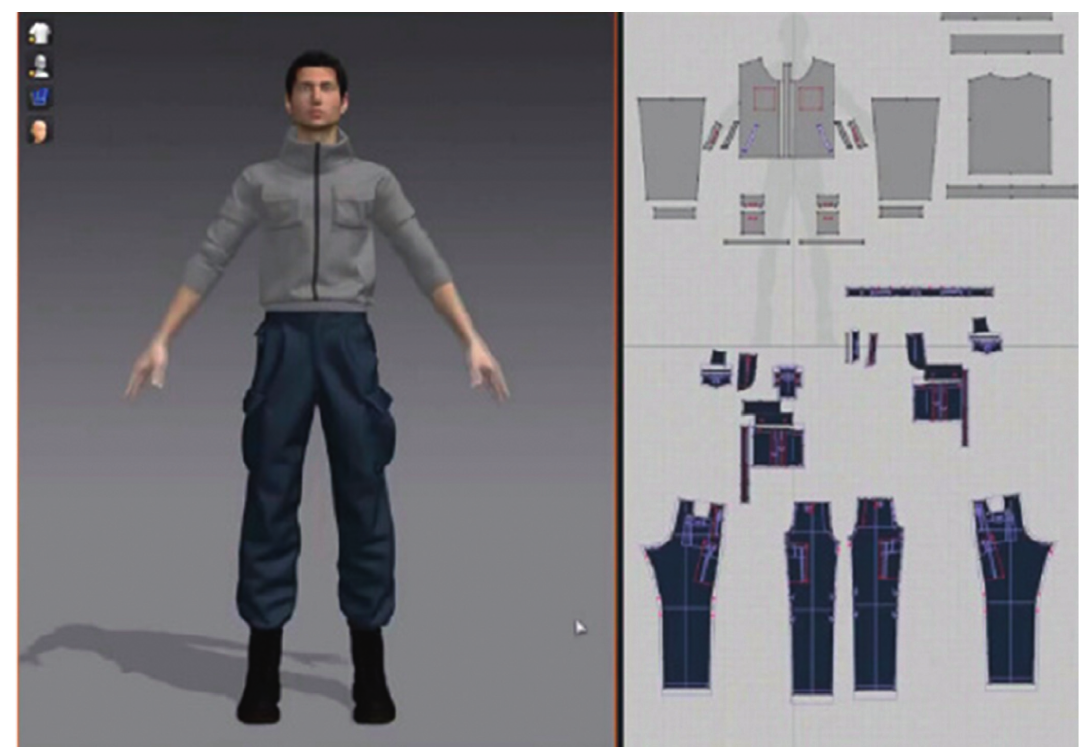
Figure 8: Clothing animation interface display